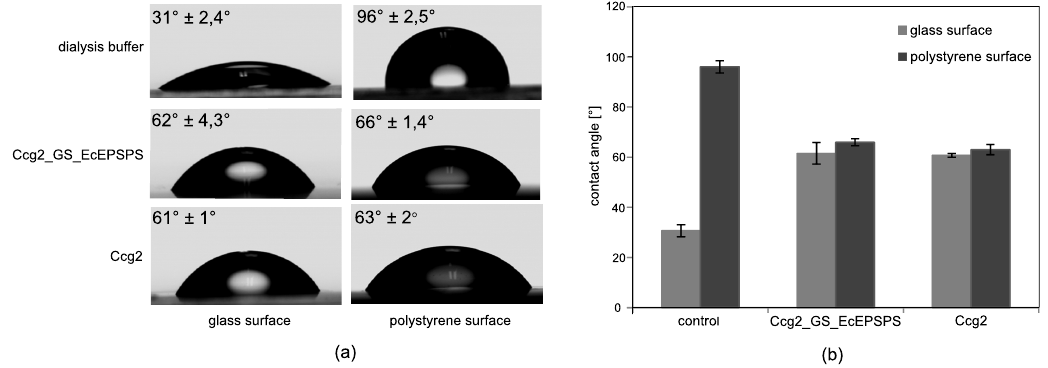
Figure 2. Water contact angle measurements on glass and polystyrene surfaces. The respective surface was treated with protein solution and then washed thoroughly with distilled water. Contact angle of a 2 µ L water droplet was determined using the OCA20 (Dataphysics) contact angle measuring instrument. ( a ) Representative drop shapes of surfaces functionalized with dialysis bu ff er (control), fusion protein (Ccg2_GS_EcEPSPS)-and hydrophobin (Ccg2)-solution. Mean values of measured contact angles are depicted in the upper left corner. ( b ) Bar graph of measured contact angles with standard deviation for 7 di ff erent drops (except Ccg2_GS_EcEPSPS (glass) = 6